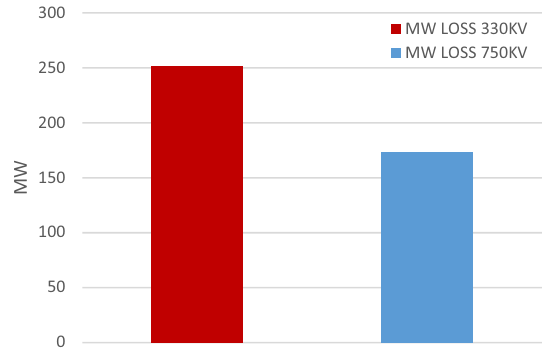
Fig. 13 The combined real power losses of 330-kV and 750-kV transmission